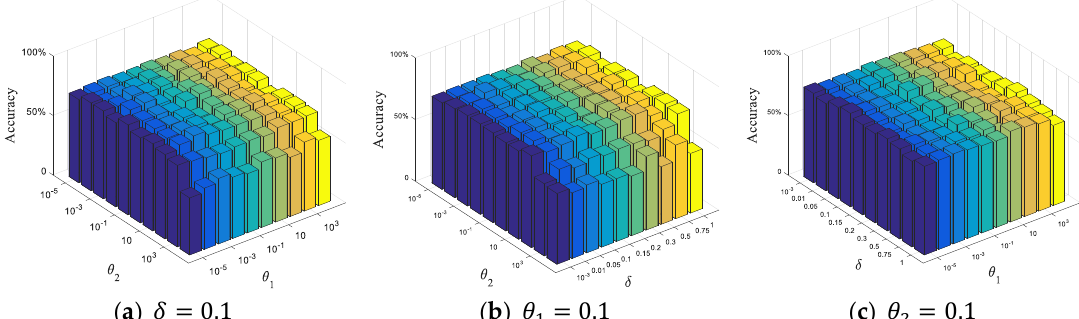
Figure 7. The histogram of the recognition accuracy with respect to the three parameters; ( a – c ) show the recognition accuracy obtained by adjusting the remaining two parameters when the corresponding parameter is fixed at 0.1, respectively. The X and Y axes represent the values of di ff erent parameters, and the z-axis represents the classification accuracy of ME recognition. Table 3. Experimental results of the di ff erent grid division parameters on CASME-I, CASME-II, SMIC, and